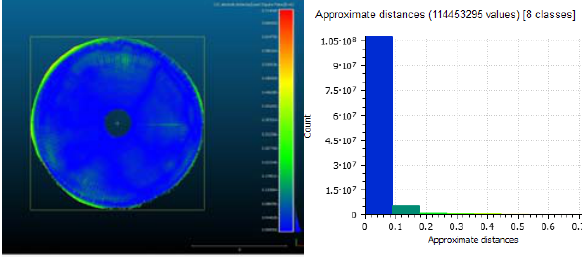
Figure 12: Discrepancy (m) map and histogram between the TLS point cloud and Photoscan processing.